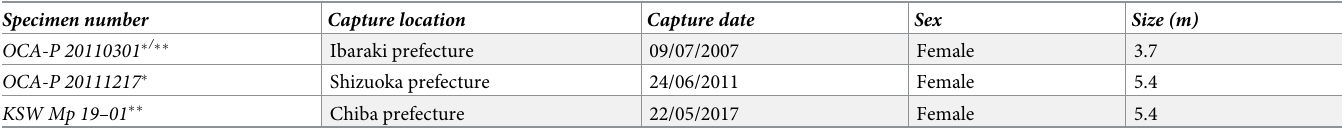
Table 1. Information on the megamouth shark